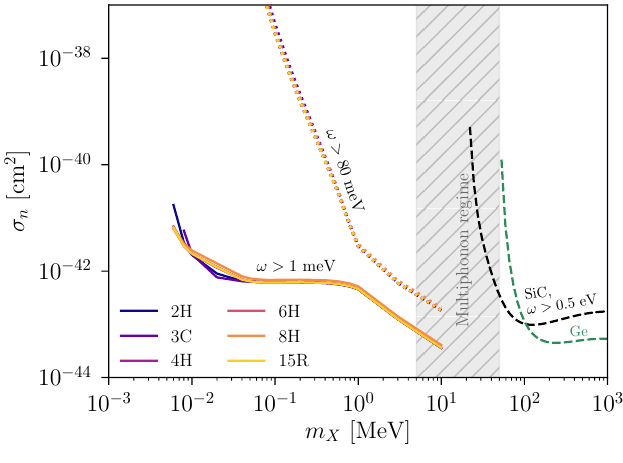
Figure 12: Reproduced from Ref. [ 66 ] . Sensitivity of a SiC target to DM-nucleon interactions with a massive mediator. Results are shown assuming kg-year exposure and zero background and for scattering into acoustic phonons ( ω > meV) and for ≈ 35 meV). Also shown are example nu- scattering into optical phonons ( ω = ω LO clear recoil